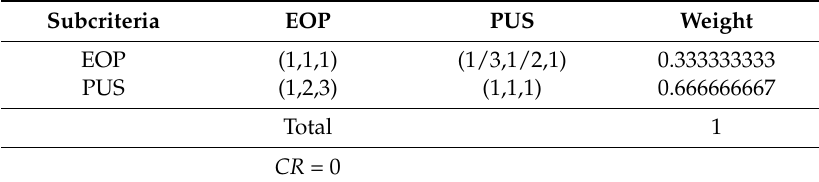
Table A20. Comparison matrix for REP.